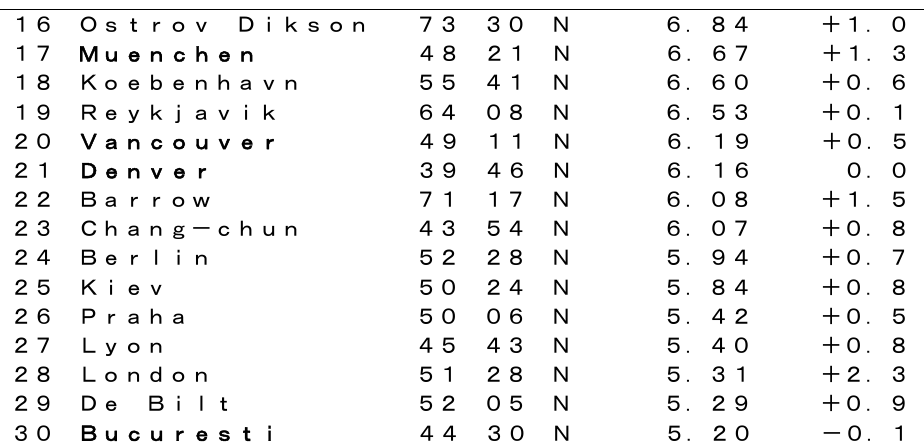
Climate 2020 , 8 , 128